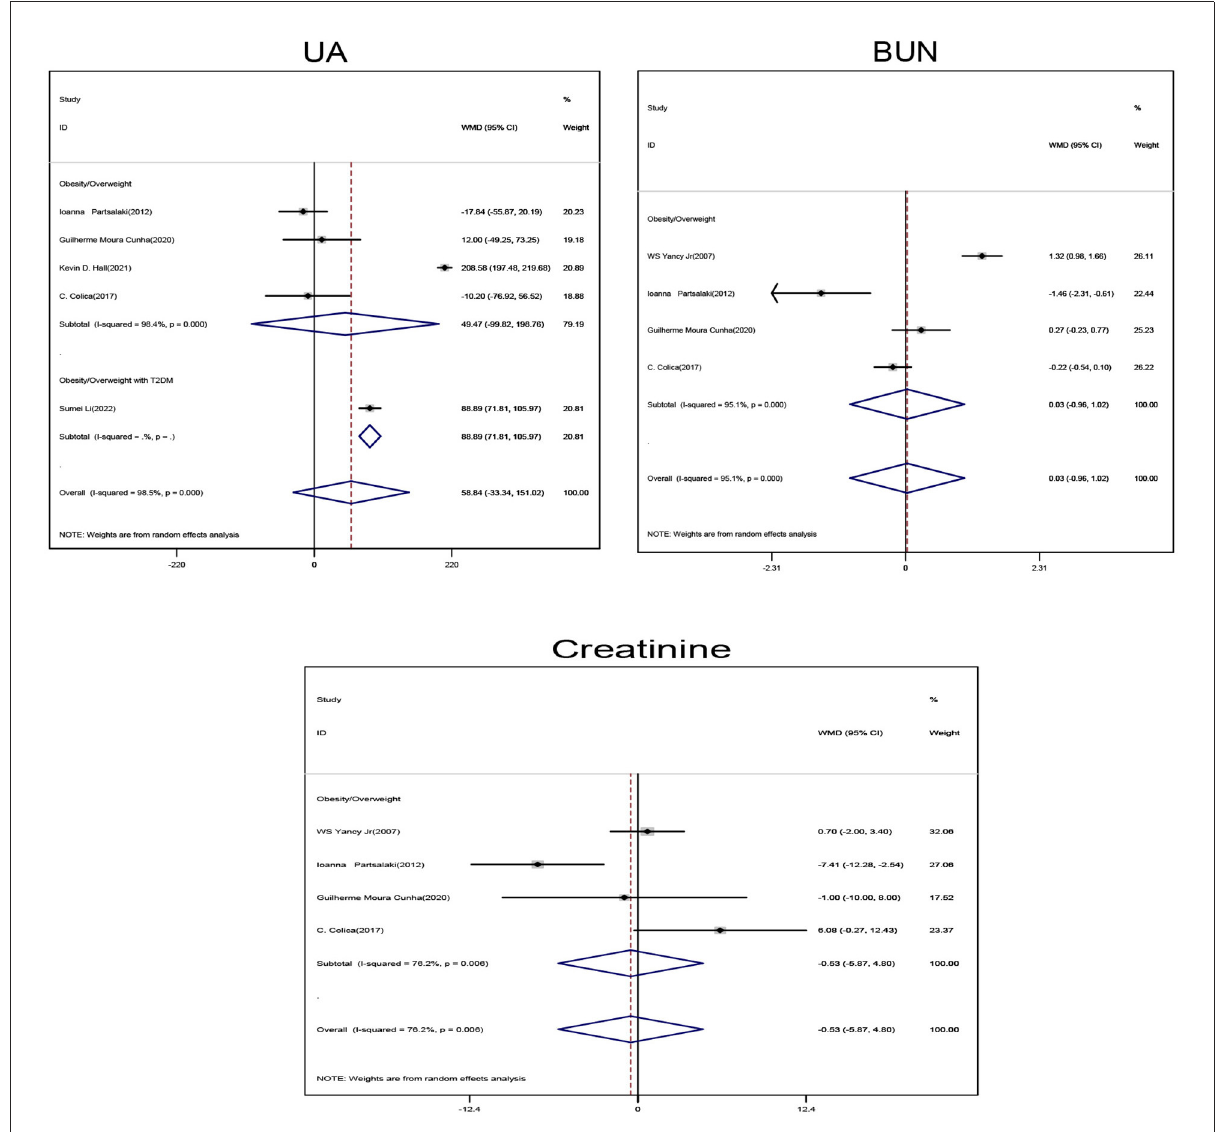
FIGURE4 Forest plot showing weighted mean difference and 95% confidence intervals (CIs) for low carbohydrate ketogenic diet effects on kidney related functions. UA, Uric acid; BUN, Urea